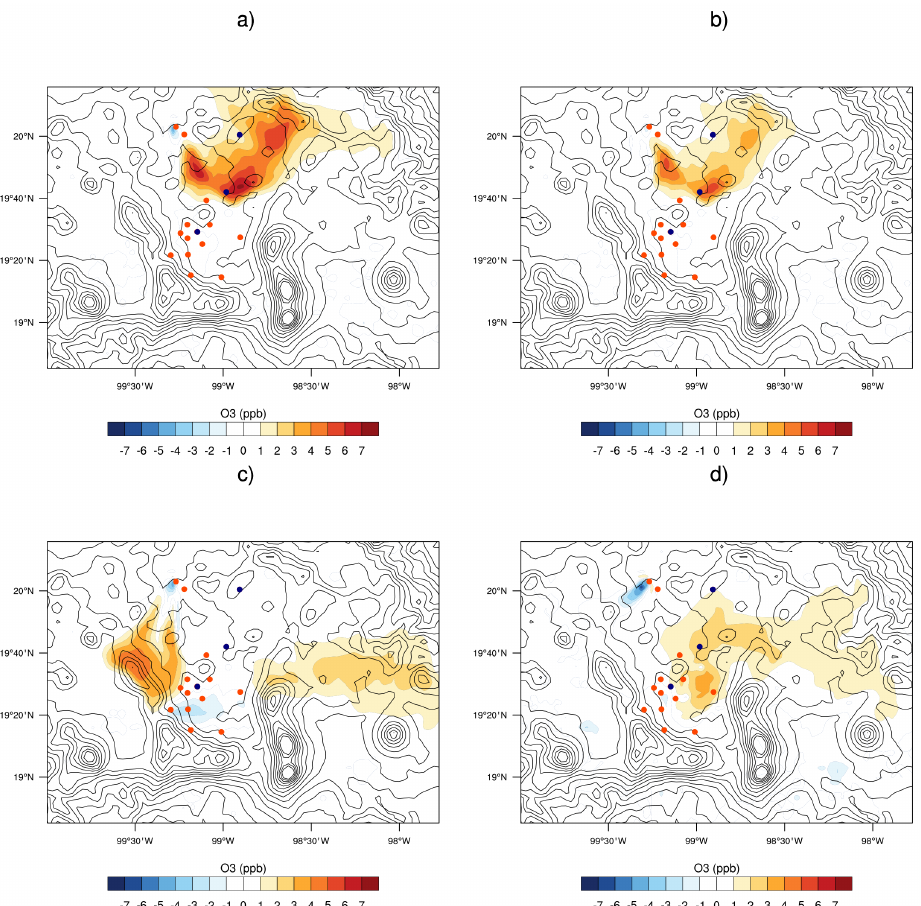
Figure 8. Suggested contribution to regional ozone levels: (a) plume from the TIC-generated precursors on 25 March at 15:00LST; (b) plume from flaring-generated precursors on 25 March at 15:00LST; (c) plume from the TIC-generated precursors on 23 March at 13:00LST; and (d) plume from the TIC-generated precursors on 25 March at 18:00LST. Blue dots represent supersite locations and orange dots monitoring stations. Ozone units are in